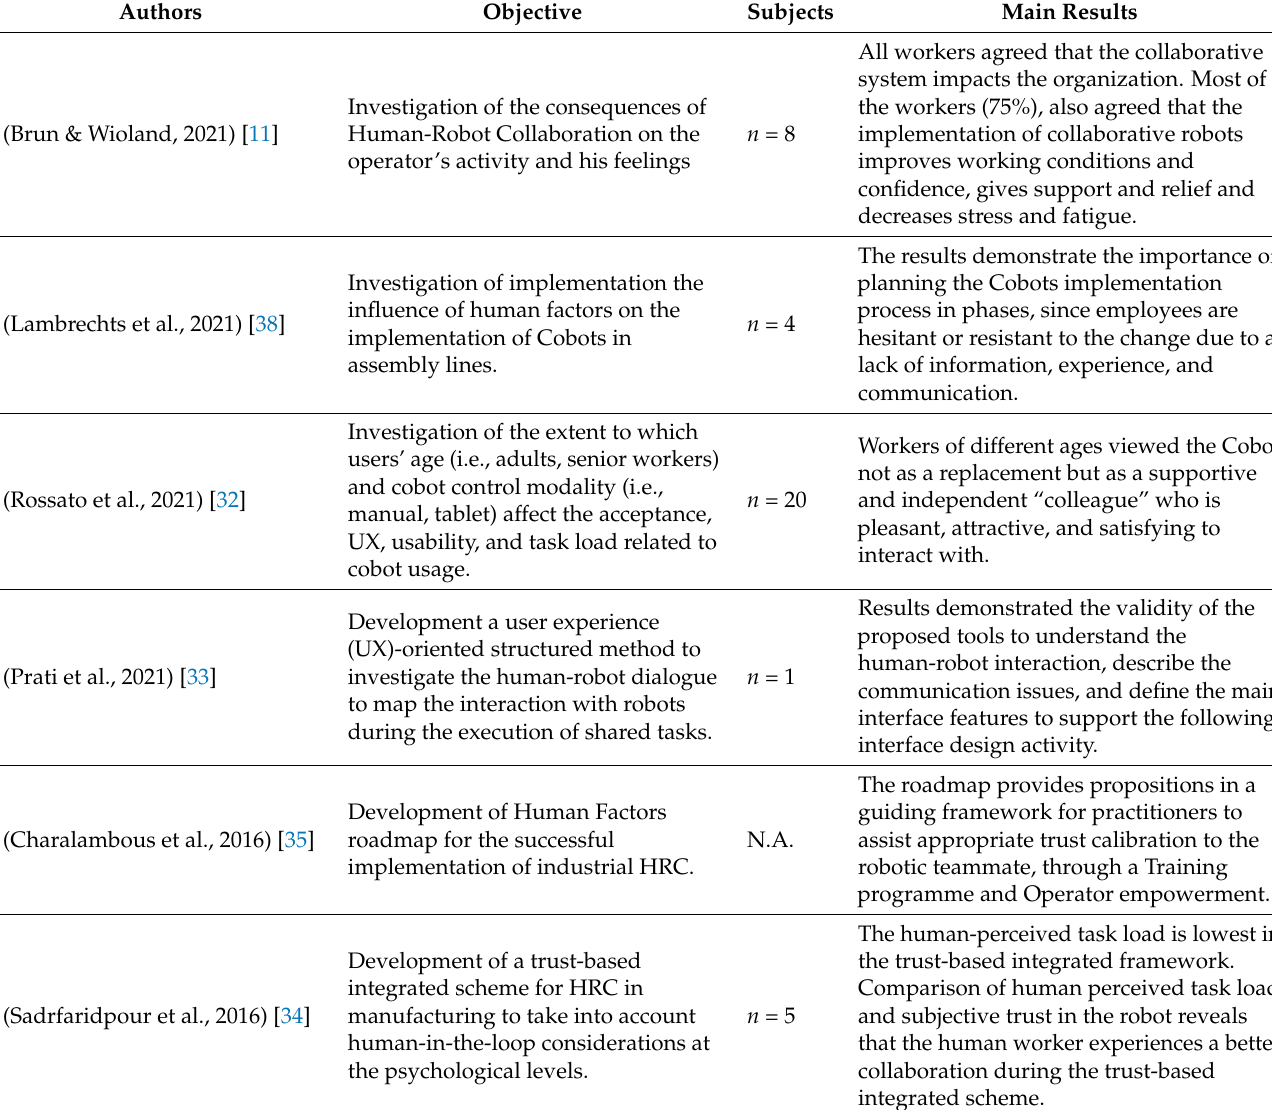
Table 2. Summary of the reviewed studies related to cognitive ergonomics (presented in chronological order of publication).